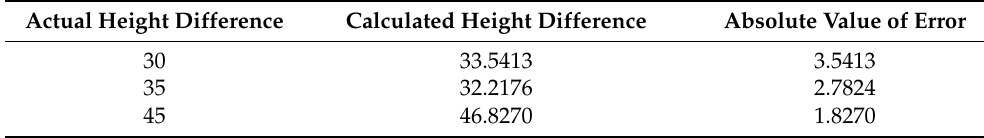
Table 1. Height-difference calculation results